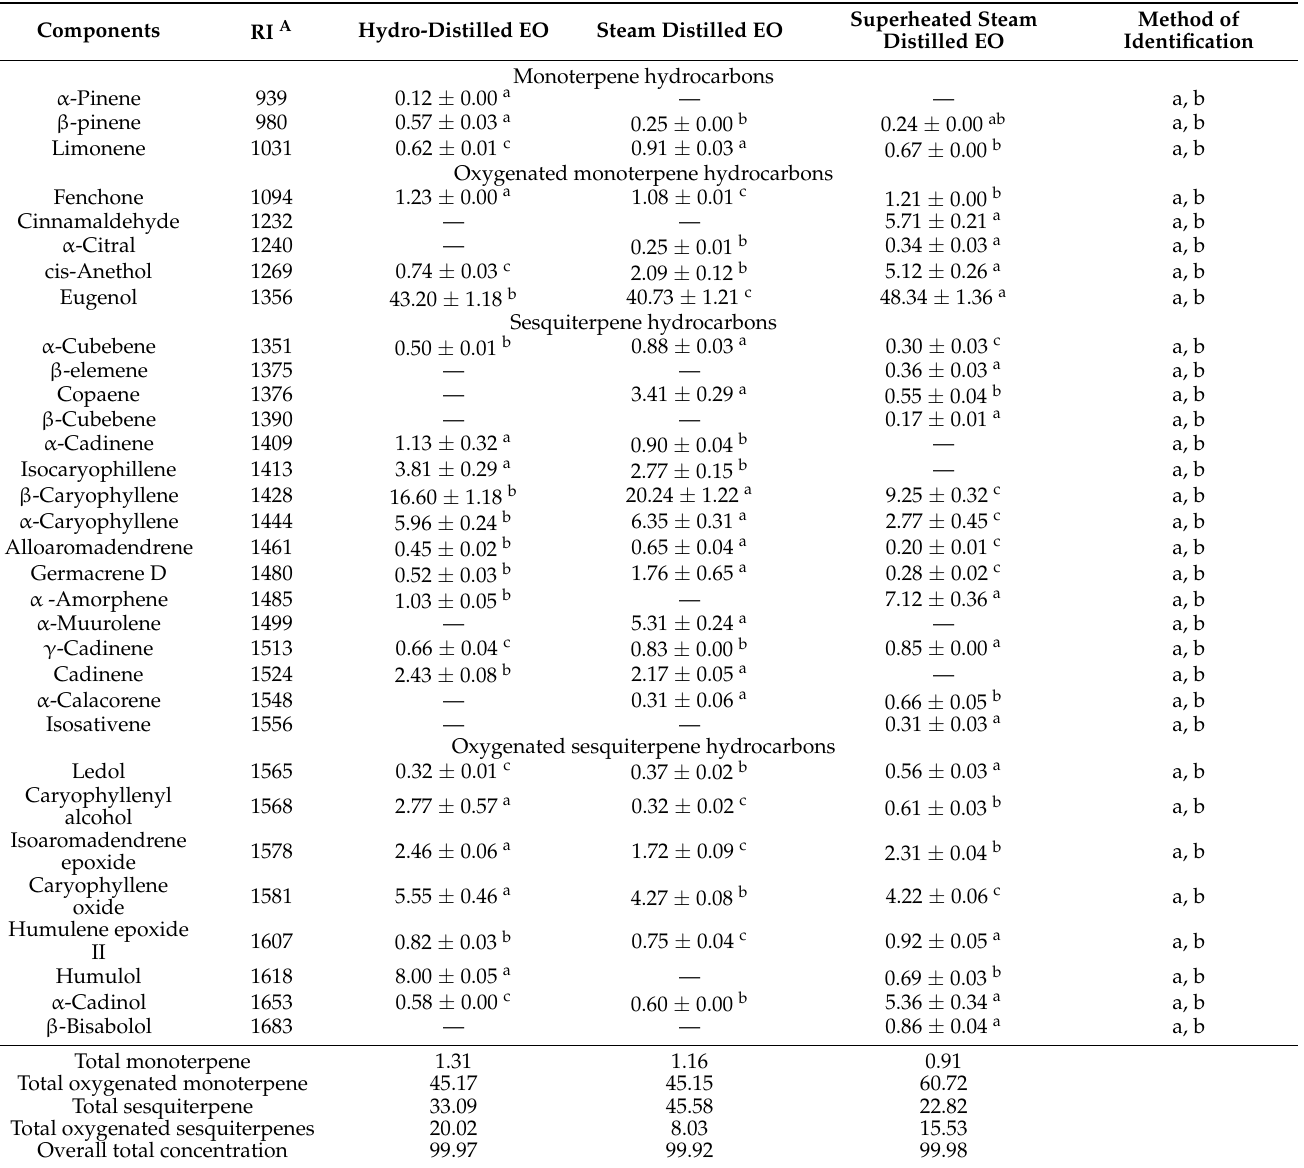
Table 2. GC-MS results (% composition) of S. aromaticum EOs derived from different extraction